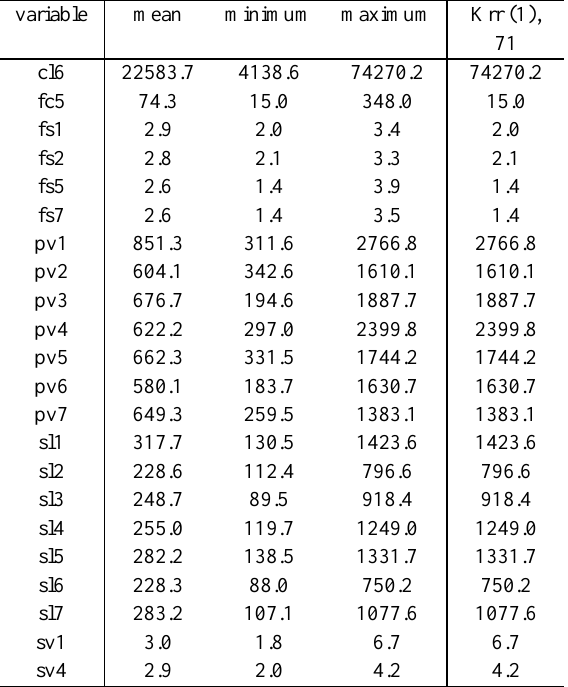
Table 9 Some of the values of the greatest difference among the